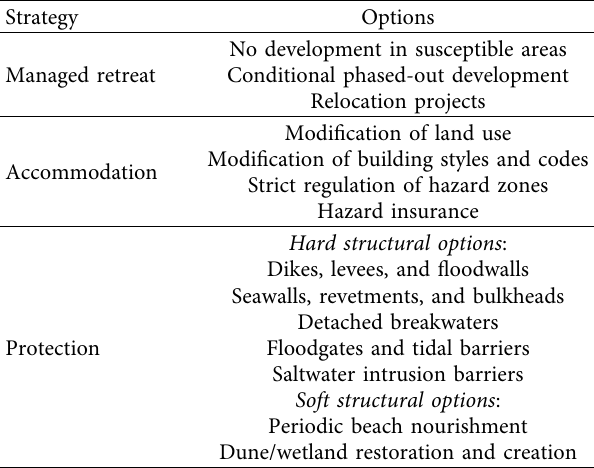
Table 1: Framework for assessing adaptation strategies and op- tions